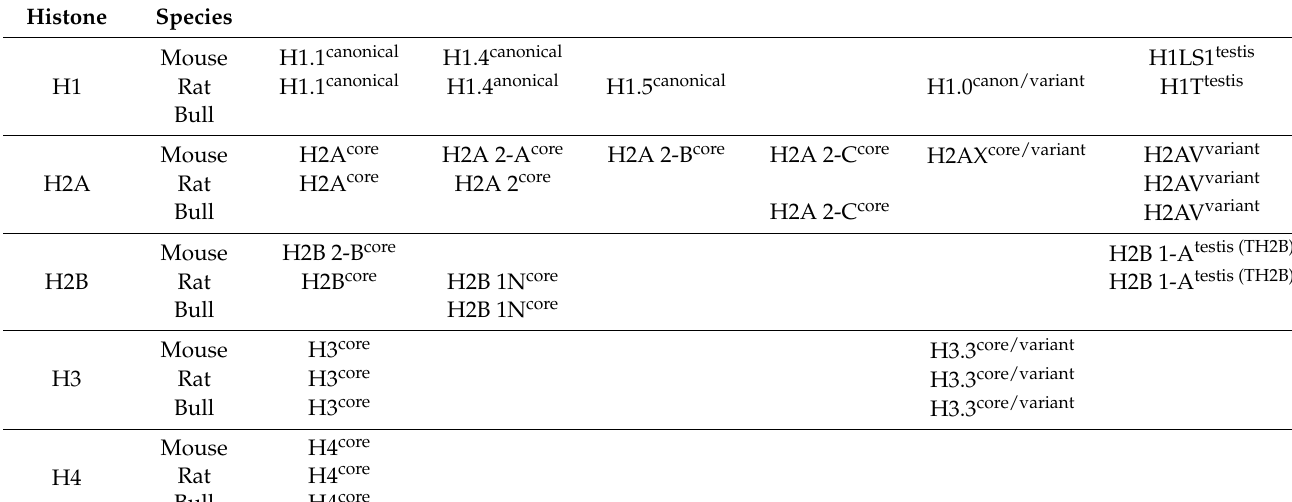
Table 1. Comparison of mass spectrometry analyses of PT histones between species.